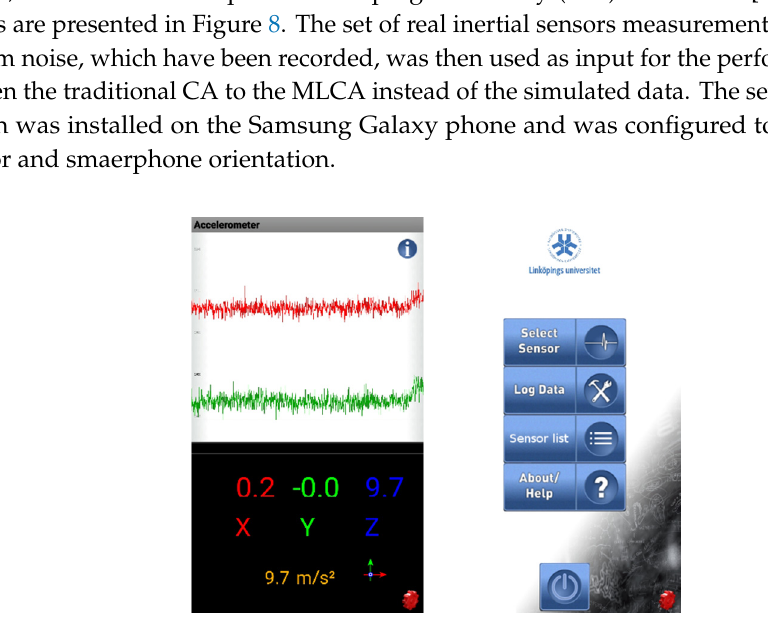
Figure 7. Wide range error values using CatBoost CA vs. classical CA. ( a ) Roll error; ( b ) Pitch error.